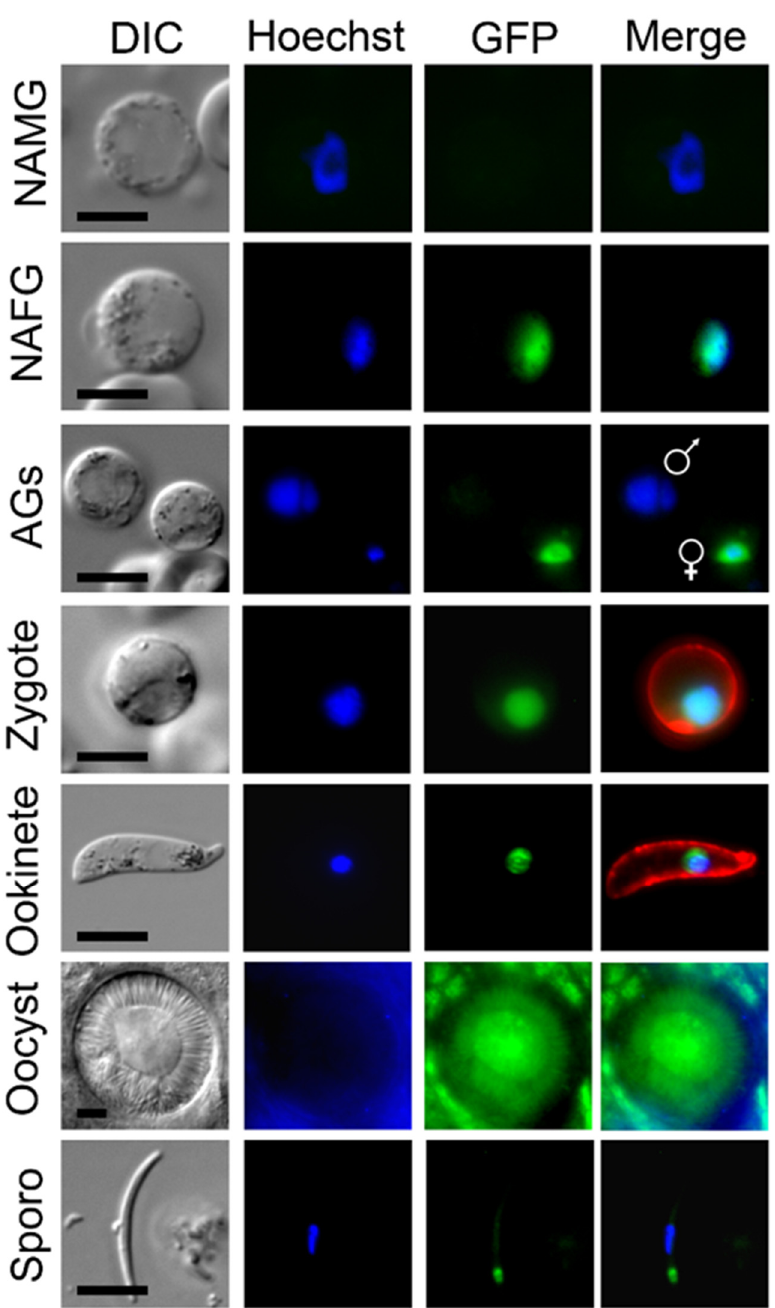
Figure 1. PbMRE11-GFP protein expression throughout most stages of the life cycle. Expression of PbMRE11-GFP in gametocytes, zygotes, ookinetes, oocysts and sporozoites. No GFP expression was observed in the asexual ring, trophozoite or schizont stages. NAMG = non-activated male gametocytes; NAFG = non-activated female gametes; AGs = activated gametocytes. Scale bar = 5 μ m.